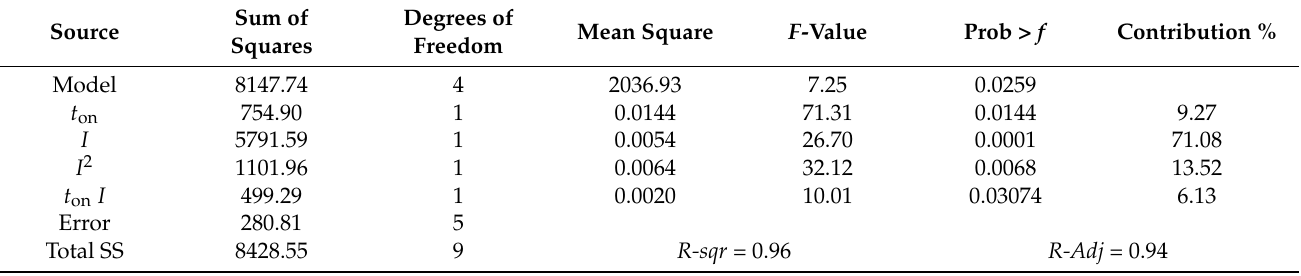
Table 8. ANOVA table for MRR (after